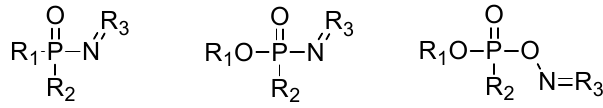
ClF Figure 3. Possible A-series nerve agents, as reported by Hoenig [12]. Figure 4. Possible structures of A-series nerve agents,as reported by Ellison [14] and Patocka [13]. 5. Synthesis of A-series Nerve Agents Discussion about the A-series nerve agents must be done carefully. Those compounds have not been confirmed yet, and most of the information available today is speculative or comes from questionable sources. One relevant aspect of the proposed synthetic route is related to the idea behind